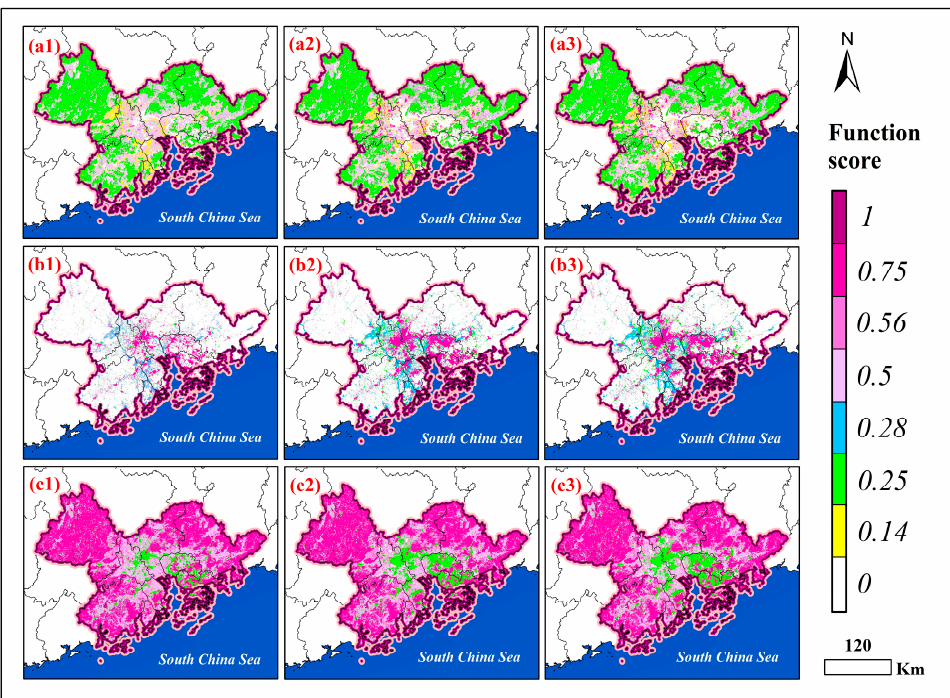
Figure 5. The spatial and temporal distribution pattern of production-living-ecological space in the GBA from 2000 to 2020, ( a1 – a3 ) show the function and distribution of the production space during 2000–2020; ( b1 – b3 ) show function and distribution of the living space during 2000 to 2020; ( c1 – c3 ) show function and distribution of the ecological space during 2000–2020.